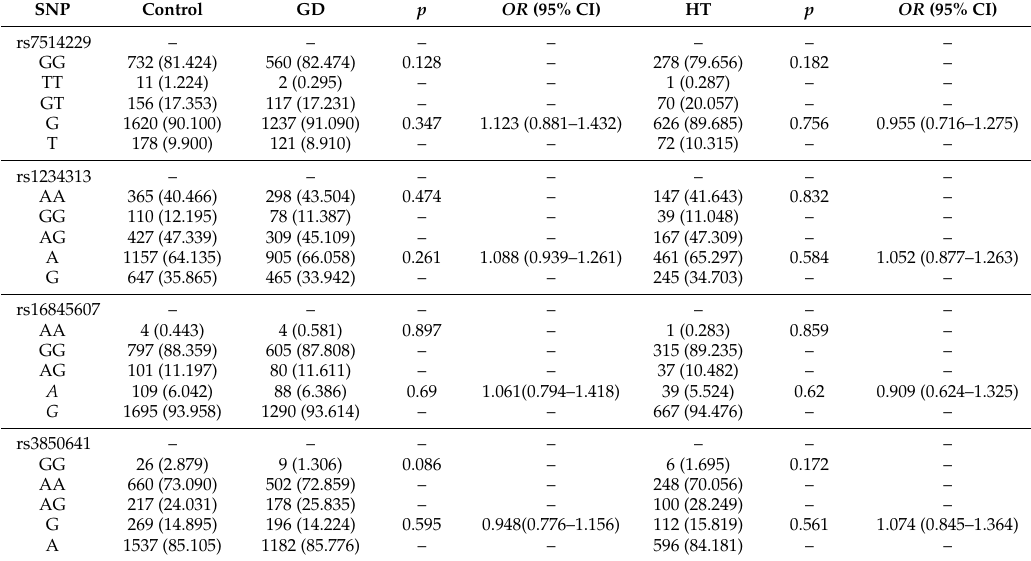
Table 4. Distribution of genotype and allele of TNFSF4 gene in sub-clinical types of AITDs patients and